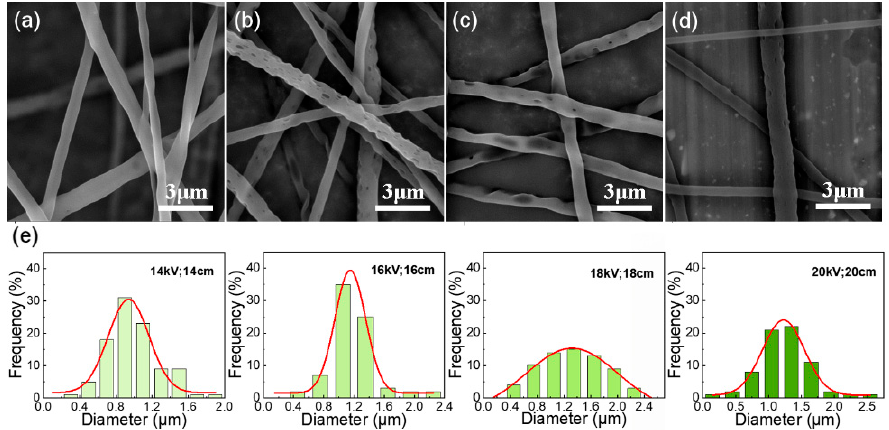
Figure 6. SEM images of the electrospun fibrous membrane with different voltage and collecting distance, ( a ) 14 kV, 14 cm; ( b ) 16 kV, 16 cm; ( c ) 18 kV, 18 cm; ( d ) 20 kV, 20 cm; ( e ) Gaussian fitting curve of fiber diameter distribution prepared under different voltages and collecting distances.